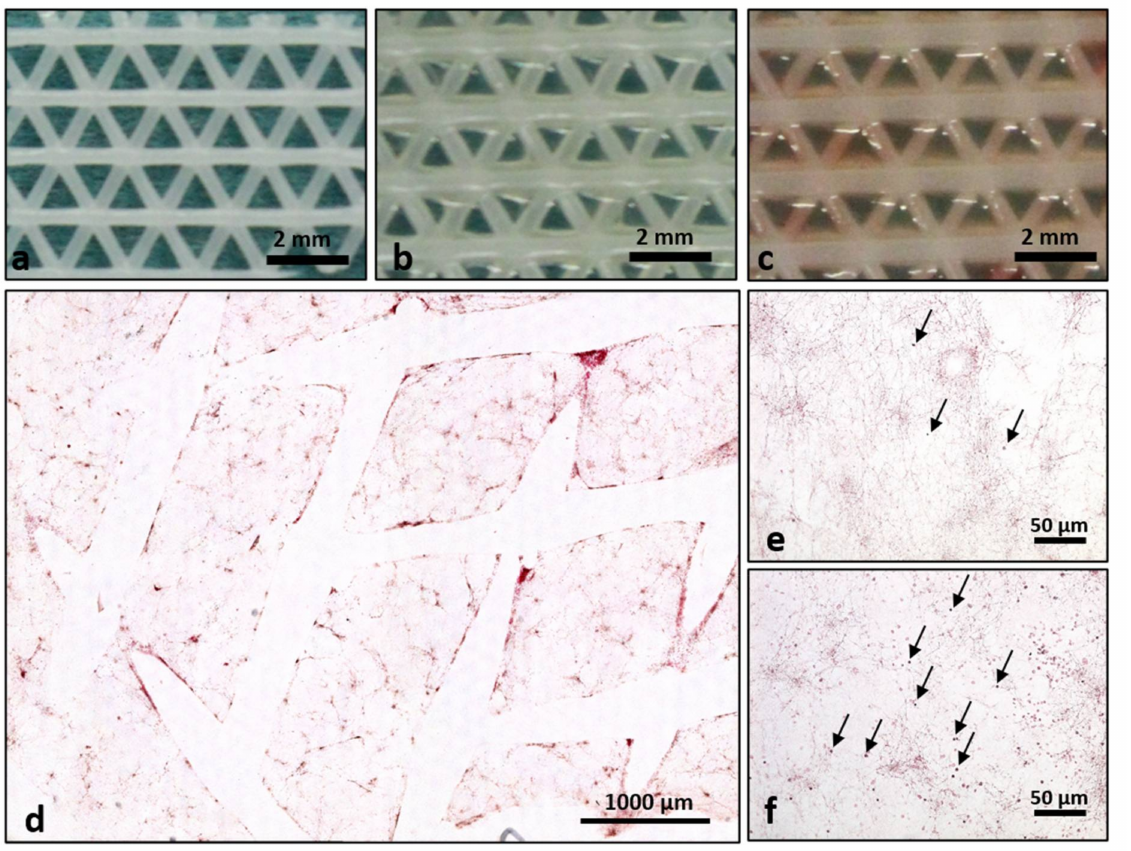
Figure 1. ( a – c ). Overview of material structure of ( a ) Osteopore alone, ( b ) Osteopore with PRF High and ( c ) Osteopore with PRF Low . ( d – f ) Comparison of platelet rich fibrin (PRF) morphology of coated PCL material with high and low RCF PRF (OP+PRF High and OP+PRF Low ) without addition of primary cells. ( d / f ) Osteopore with PRF Low and ( e ) Osteopore with PRF High .Black arrows point to mononuclear blood